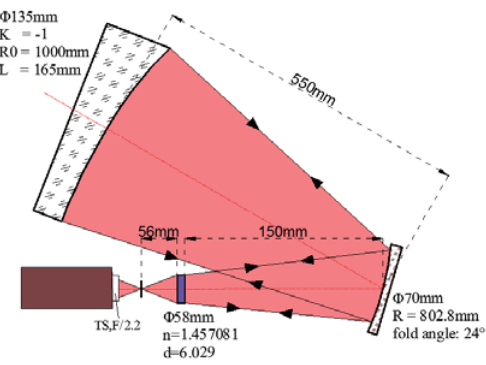
Figure 9. The geometry parameters of measuring this OAP via the hybrid compensation method.